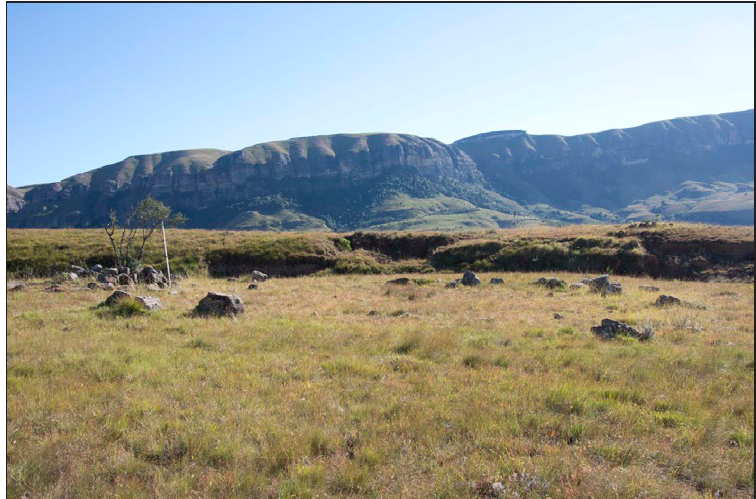
Figure 3: View over the Woodcliffs site showing its position on a spur overlooking a wide valley. Some stone walling is visible on the surface. Photo: D.